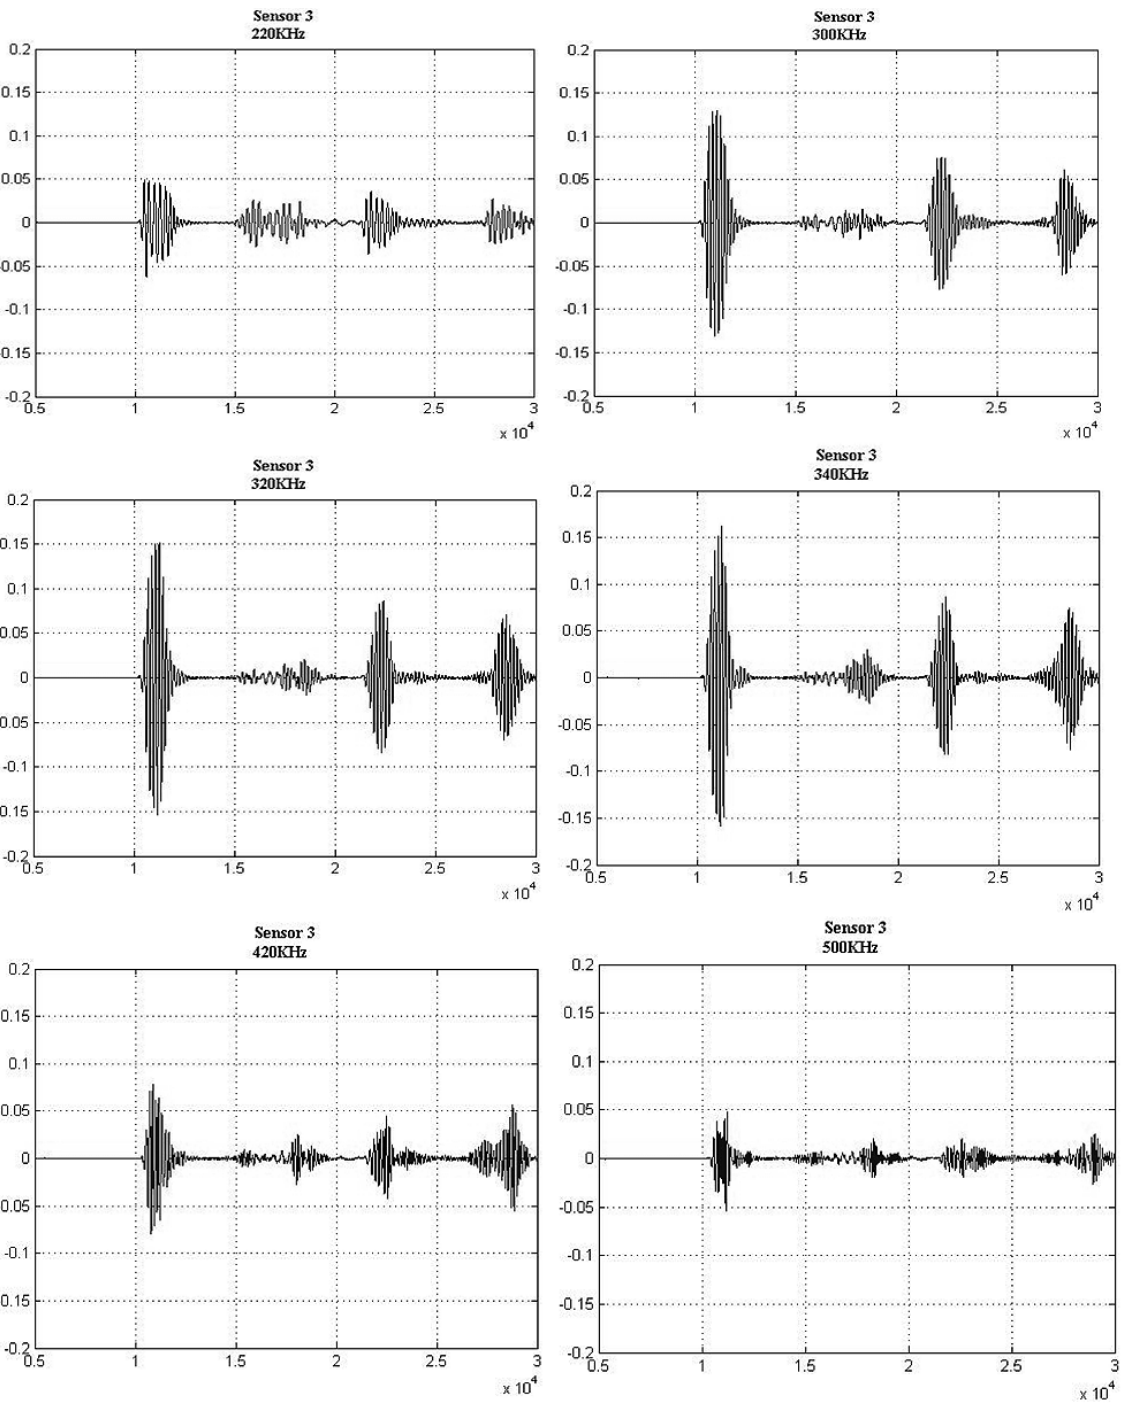
Fig. 11. Evolution of sensor signals for particular frequencies, during the initial frequency sweep, depicting propagating actuation waves S 0 , A 0 and boundary